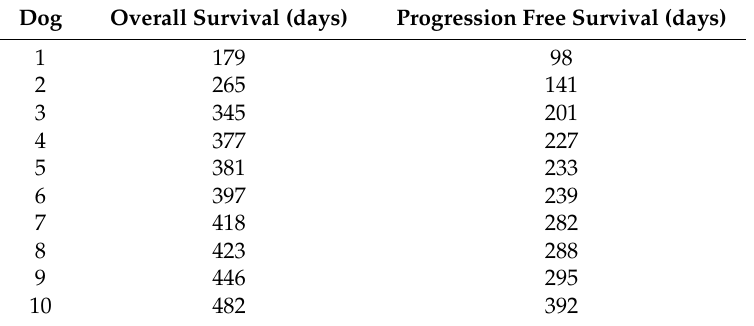
Table 4. Data for the Kaplan Meier analysis. The only censored data is for the 10th patient. Dog Overall Survival